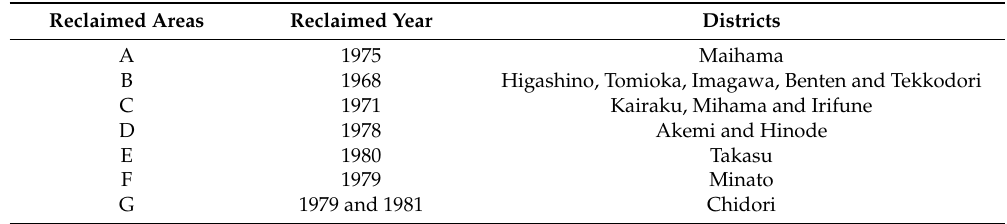
Figure 1. The map of the study area, Urayasu City, Japan. ( a ) The geographic location of Urayasu City; ( b ) the distribution and development history of the reclaimed areas, namely Moto-Machi (old town) outlined in green, Naka-Machi (central town) outlined in yellow and Shin-Machi (new town) outlined in red. A to G represent the reclaimed areas at different times. The background image is a Phased Array L-band Synthetic Aperture Radar onboard the Advanced Land Observation Satellite (ALOS-2 PALSAR-2) intensity image acquired on 4 December 2014; and ( c ) the topography of the study area [36]. Table 1. The detailed history of reclaimed areas and the districts.